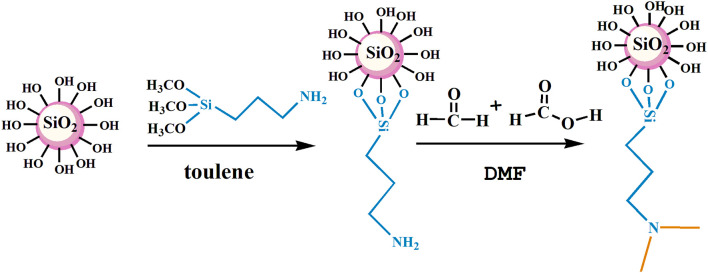
The synthesis route of responsive nano-SiO2.